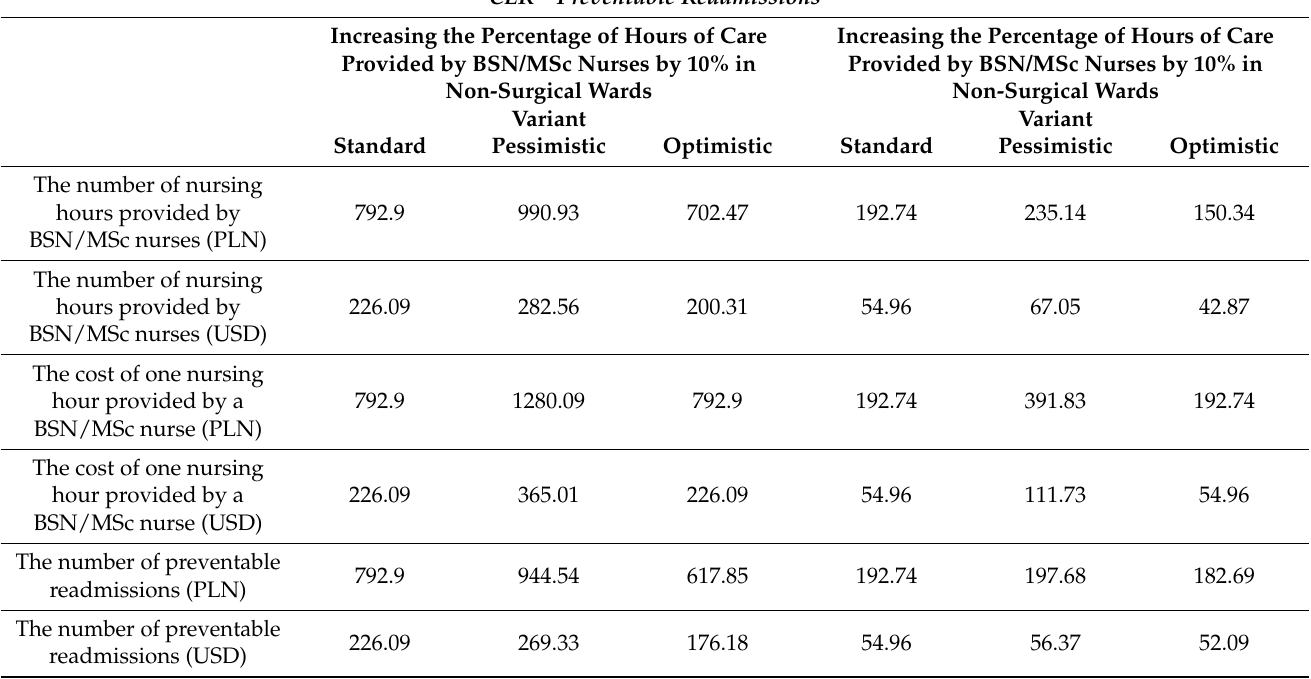
Table 5. Sensitivity